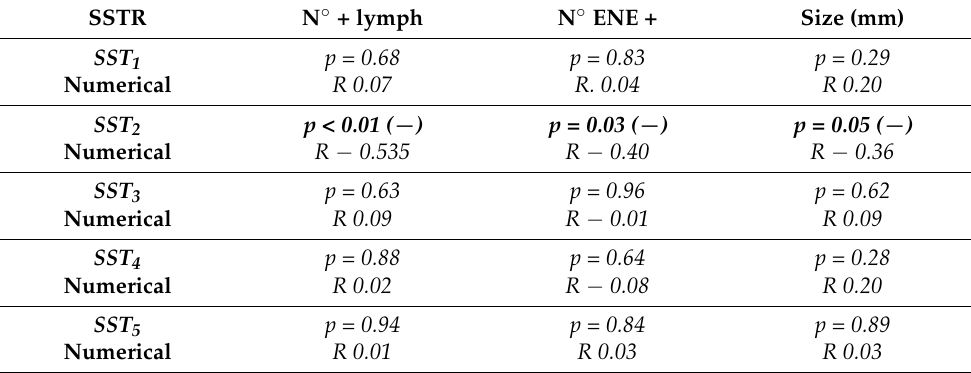
Table 5. In vivo relationship between SST-subtypes expression in OSCC and lymph node pathological data. Spearman correlation test was used for the analysis between SSTs numerical expression and lymph node results.